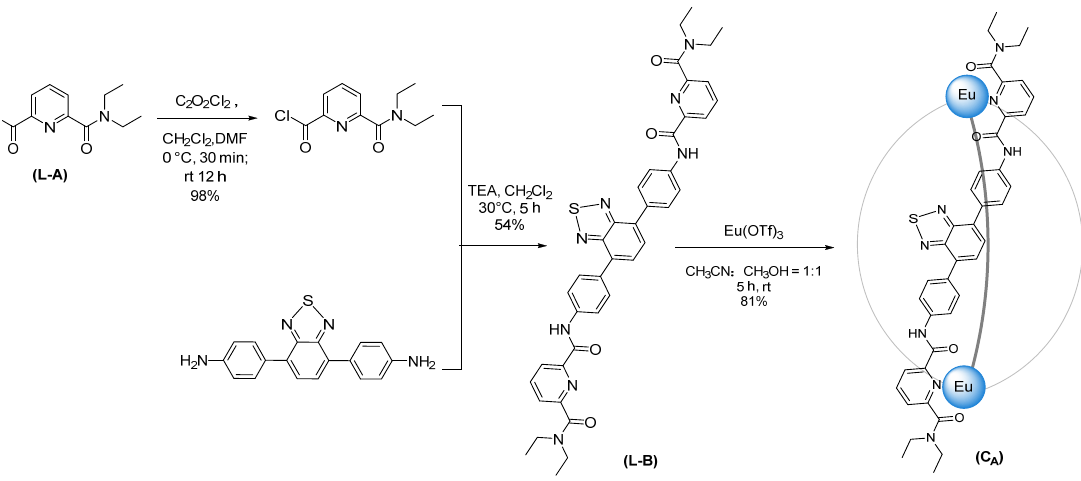
Scheme 1. Synthesis of ligand ( L-B ) and self-assembly of metal-organic cage ( C A ). Multinuclear NMR ( 1 H, DOSY, COSY, and NOSEY) analysis (Figures 2 and S10–S14),